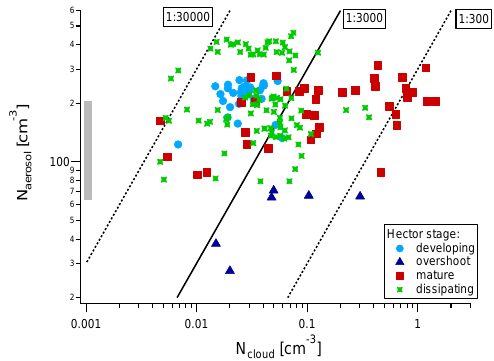
Figure 11. Activation of aerosol to cloud particles estimated by the number concentrations of aerosol and cloud particles. Each point corresponds to one size distribution in Fig. 7, with the same colour code. The overshooting Hector cases were observed at po- tential temperatures of 386–414K. The grey bar on the left denotes in-cloud aerosol concentrations observed on other flights during SCOUT-O3. The size ranges are 2.7 to 1600µm for the cloud parti- cles and larger 15nm for the aerosol particles (up to approximately 1µm). See text for further